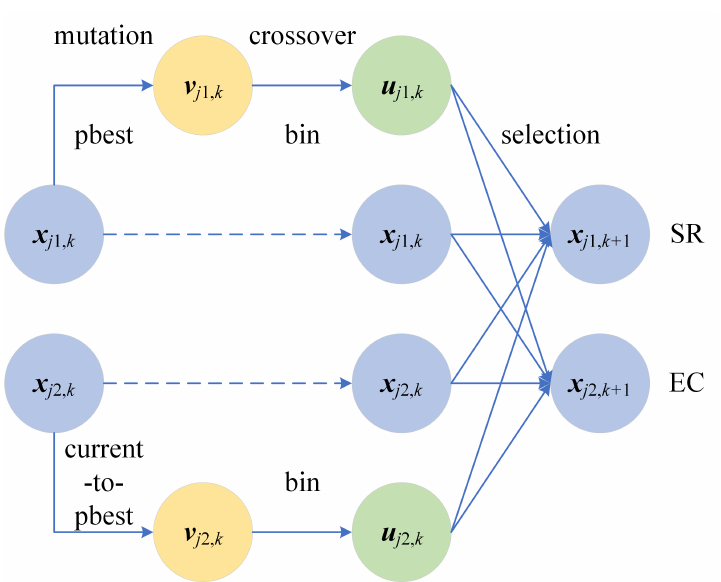
Figure 3. The framework of the mixed differential evolution